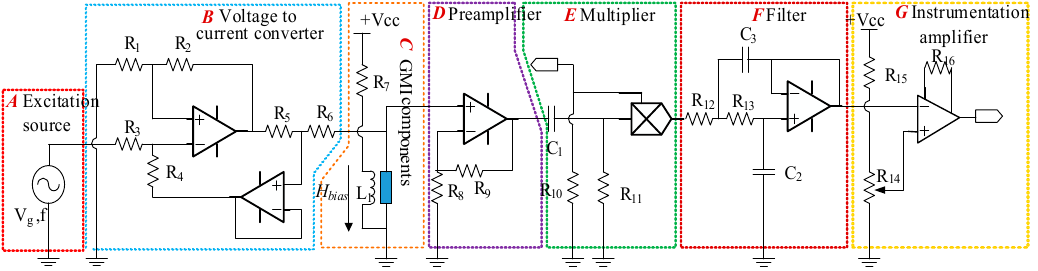
Figure 1. Schematic circuit diagram of the giant magneto-impedance (GMI) sensor.